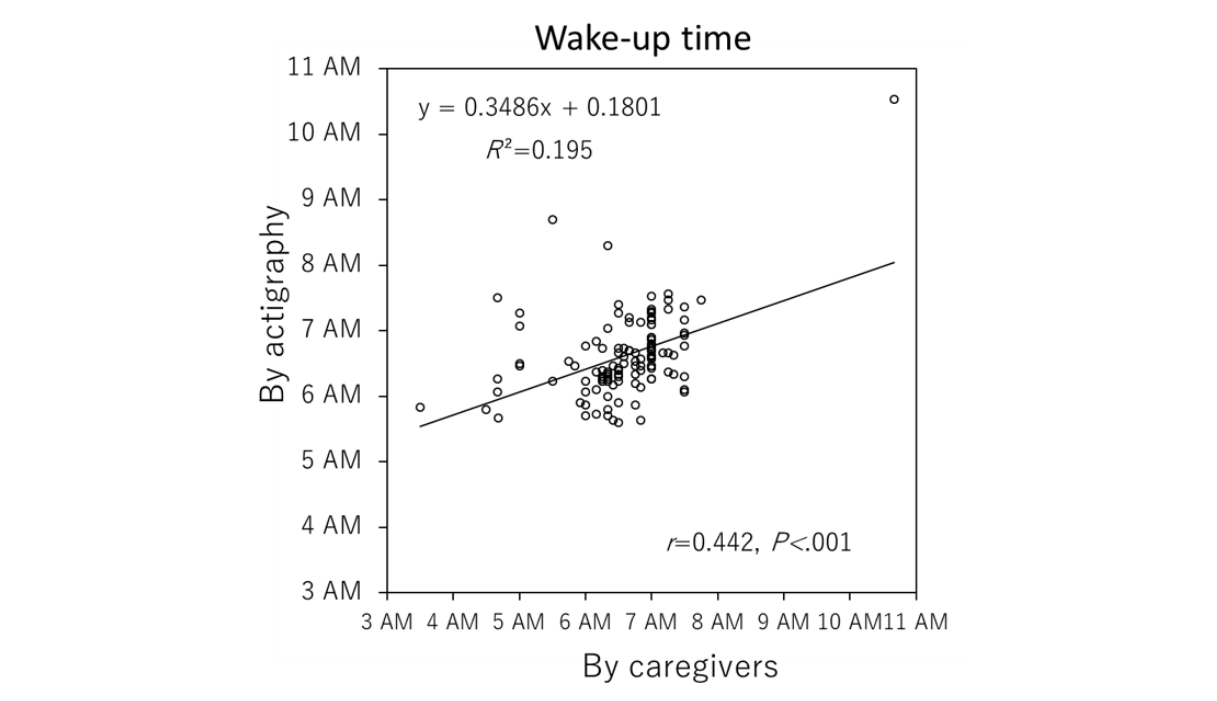
Figure 5. Scatter diagram for the entered data and actigraphy data for wake-up